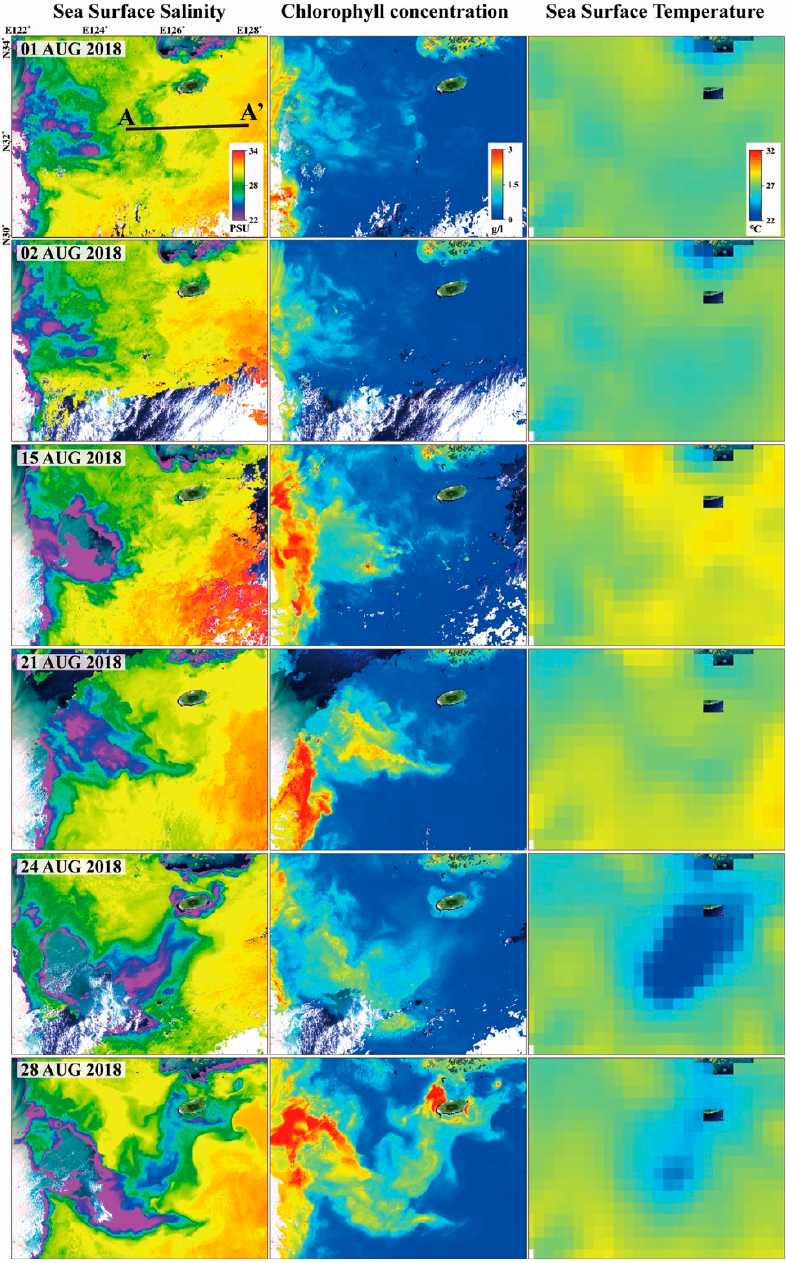
Figure 8. Daily composite SSS images derived from GOCI in this study on 1, 2, 15, 21, 24, and 28 August 2018 and the corresponding GOCI-derived CHL images (the same spatial resolution with SSS observations) and NOAA OISST SST images.